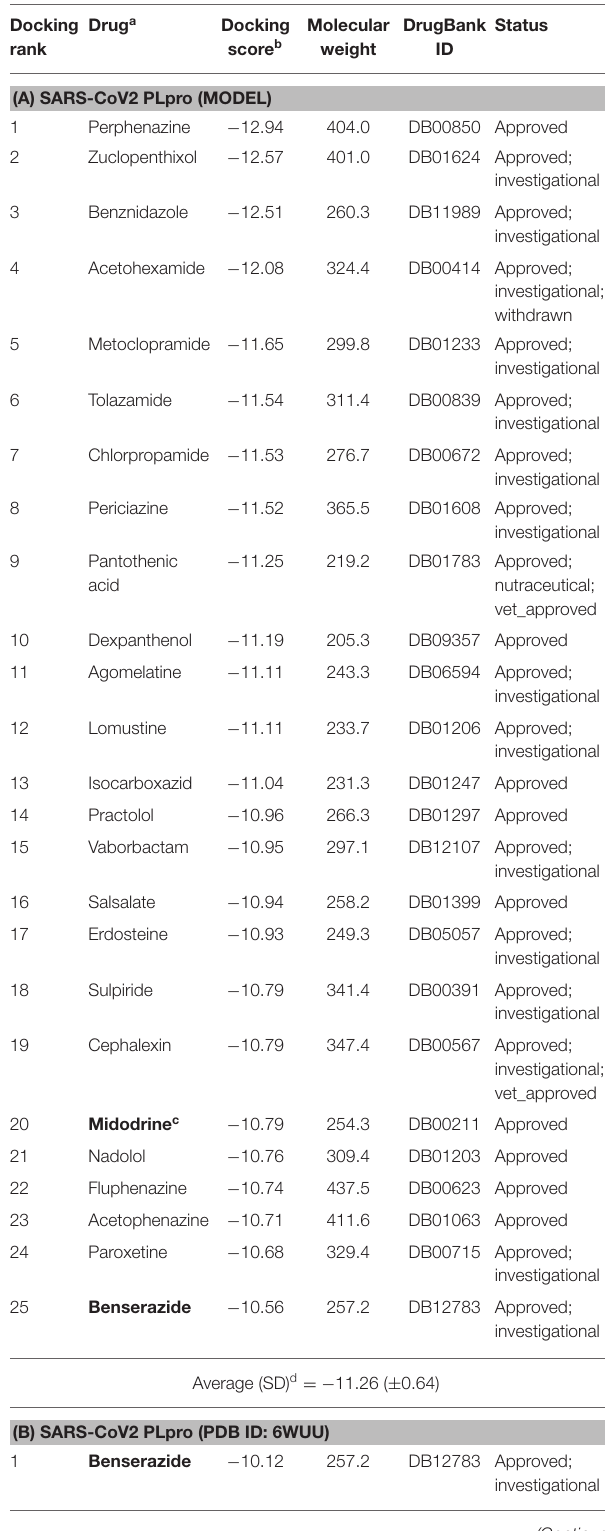
TABLE 1 | The best-ranked 1% of the VS efforts for FDA-approved drugs (DrugBank—release March 2020) against the SARS-CoV-2 PLpro homology model, the co-crystal structure (PDB ID: 6WUU), and the recently introduced co-crystal structure (PDB ID: 7JRN) for (A–C),